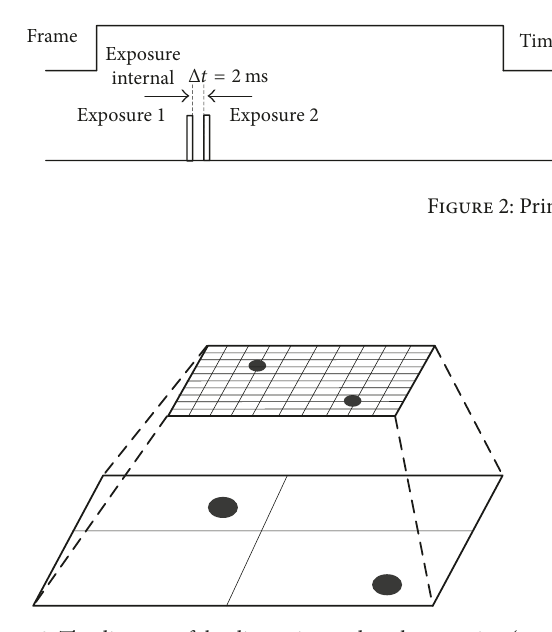
Figure 3: The diagram of the dimension-reduced processing (a grid of 10 × 10 elements is mapped onto a grid of again 2 × 2